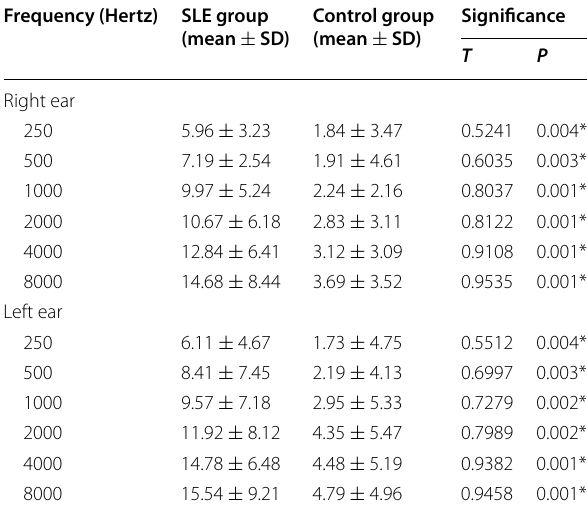
* P 0.05 significant. SLE systemic lupus erythematosus ≤ = Table 4 Bone conduction hearing thresholds in both groups Frequency (Hertz) SLE group (mean